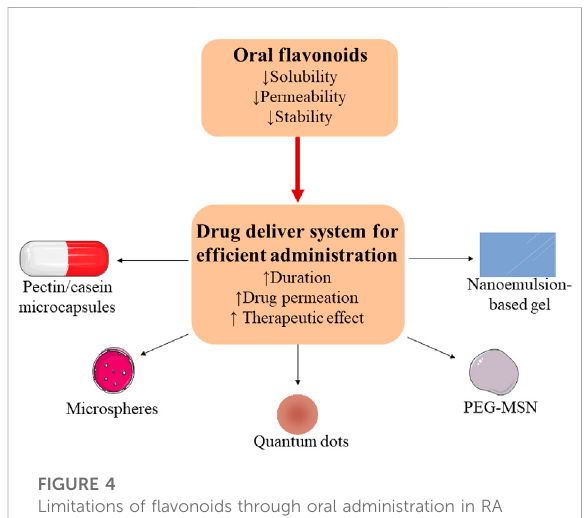
FIGURE 4 Limitations of fl avonoids through oral administration in RA therapy and their delivery systems for a promising